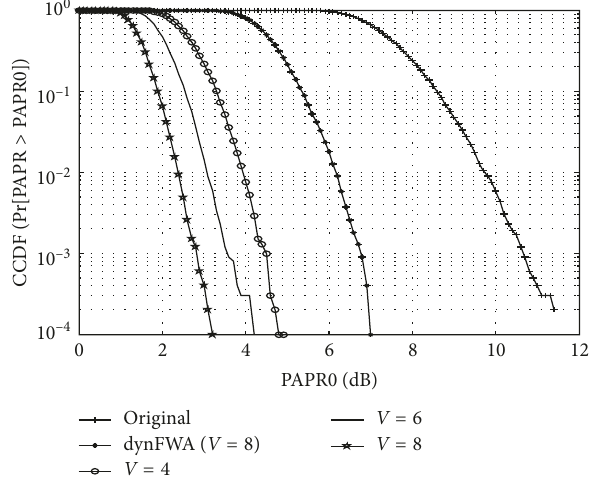
Figure 5: PAPR performance of a QPSK/OFDM system with dynFWA-based PTS technique when the number of subblocks varies.